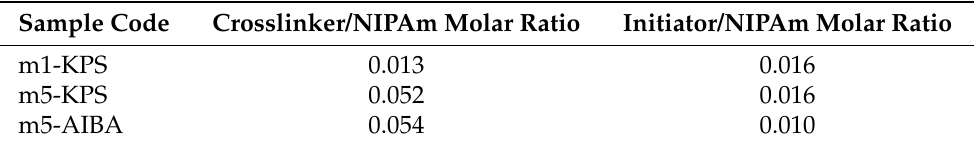
Table 1. Crosslinker/NIPAm and initiator/NIPAm molar ratios employed in FRP syntheses of the